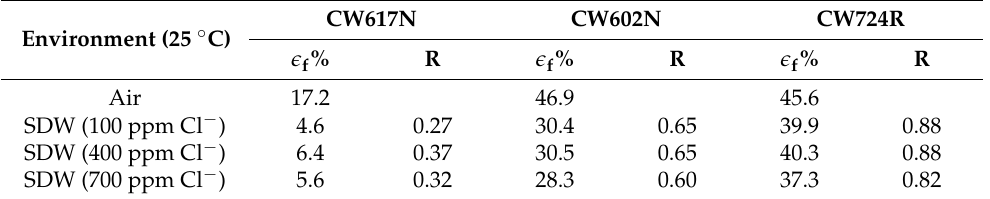
Table 3. Fracture strains ( (cid:101) f %) and SCC susceptibility index R (R = ε fs %/ ε fa %) evaluated for the different brasses in SDW solutions containing 100, 400, and 700 ppm